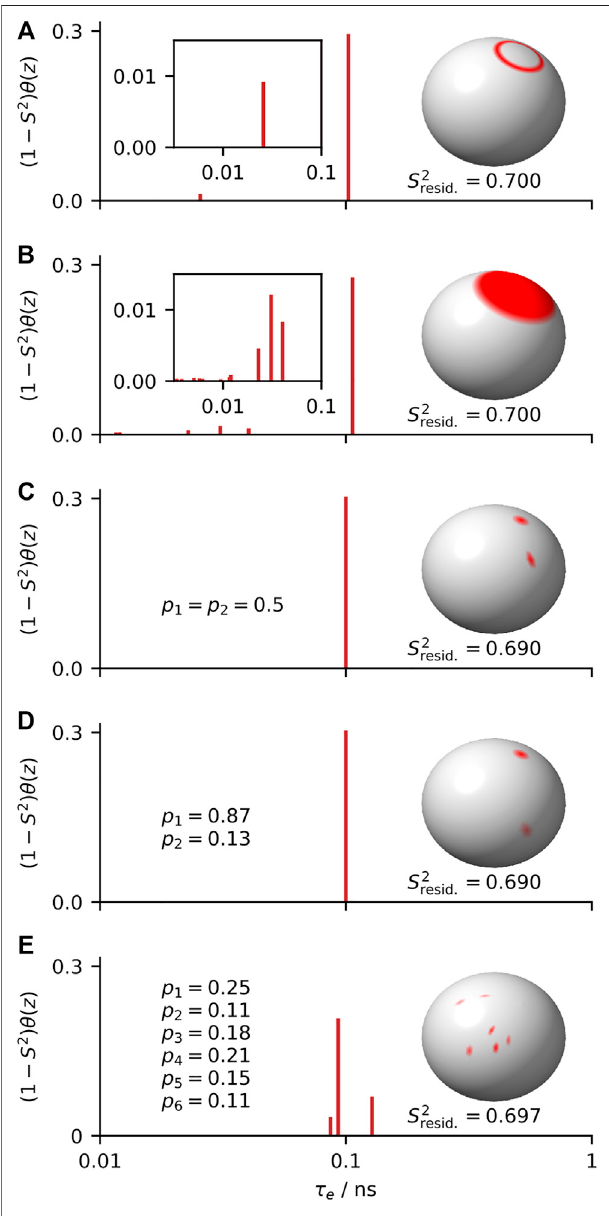
FIGURE 2 | Five distributions of orientations and correlation times that yieldthesamemodel-freeparameters( ( 1 − S 2 ) (cid:2) 0.3, 〈 τ e 〉 (cid:2) 0.1 ns).In (A – E) , we plot a distribution of orientations (sphere, right); on the axes, we plot the distribution of correlation times resulting from exchange among that set of orientations. Models of motion are wobbling-on-a-cone ( θ cone (cid:2) 19 ° ), wobbling-in-a-cone ( θ cone (cid:2) 28 ° ), symmetric two-site hop ( θ hop (cid:2) 39 ° ), asymmetrictwo-sitehop( θ hop (cid:2) 70 ° ),and6-siteasymmetricexchange.Insets in (A,B) showcorrelationtimeswithsmallamplitudes. S 2 resid . referstotheorder parameter from residual couplings (see Supplementary Section S3 ), which deviates from the generalized order parameter for asymmetric motion.